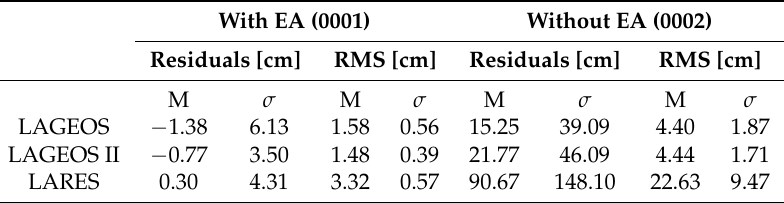
Table 4. POD statistics over the time span of the analyses. The mean (M) and the standard deviation ( σ ) of the range residuals and of their RMS are provided for the two analyses performed with and without the use of empirical accelerations (EA) With EA (0001) Without EA (0002) Residuals [cm] RMS [cm] Residuals [cm] RMS [cm] M σ M σ M σ M σ LAGEOS −